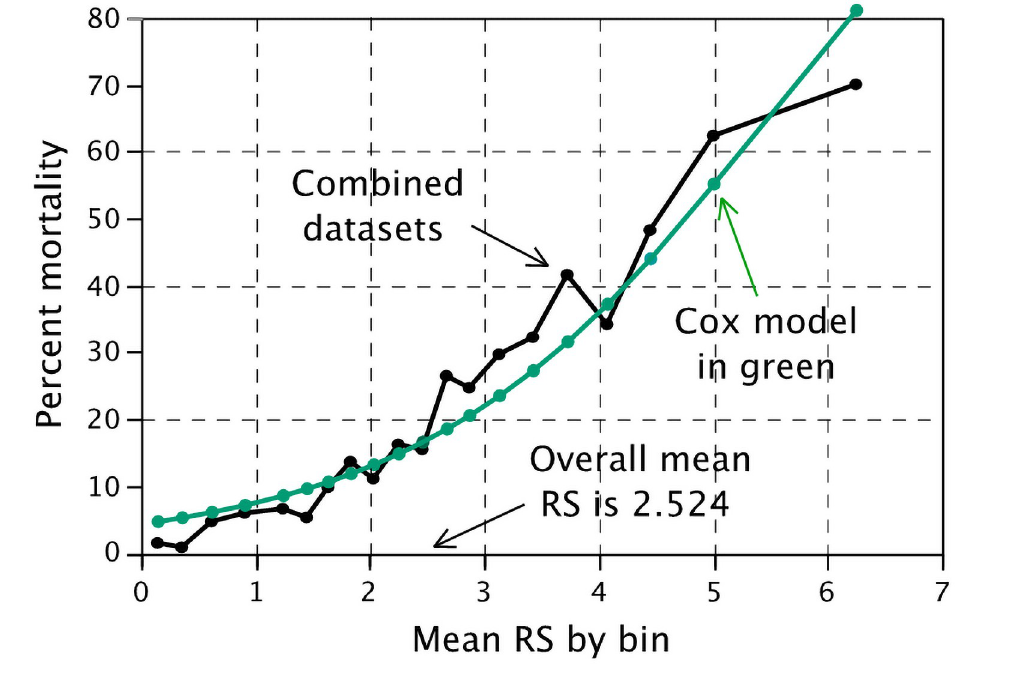
Fig 3. Patient mortality risk by day 40 using a proportional hazards